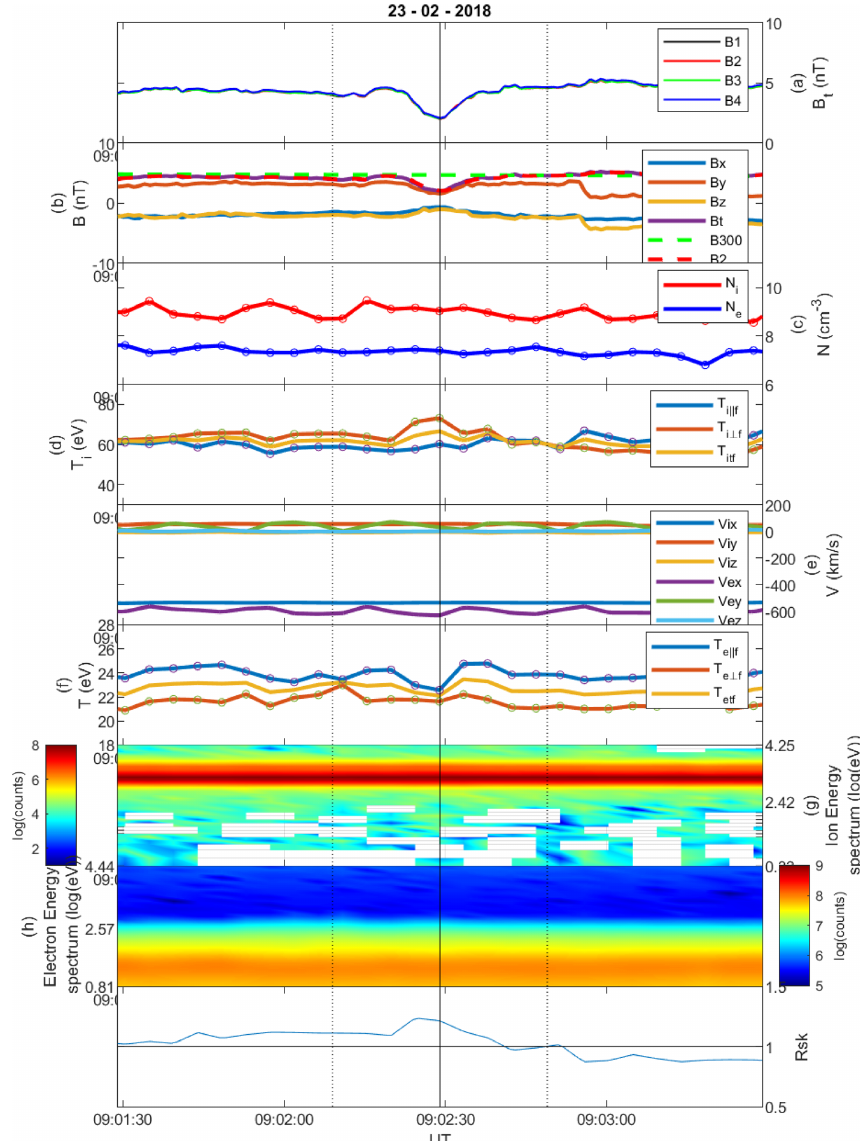
Figure 8. Linear magnetic hole on 23 February 2018, category hot. Format as in Fig.